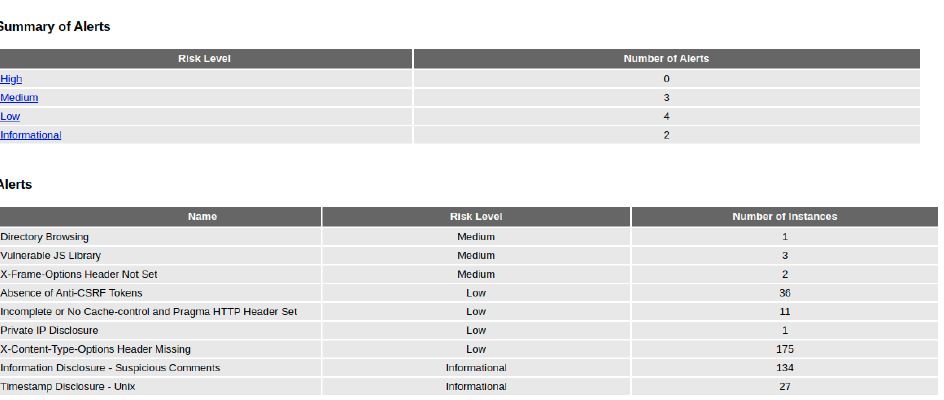
Figure 10. Security test with the C3Web system.